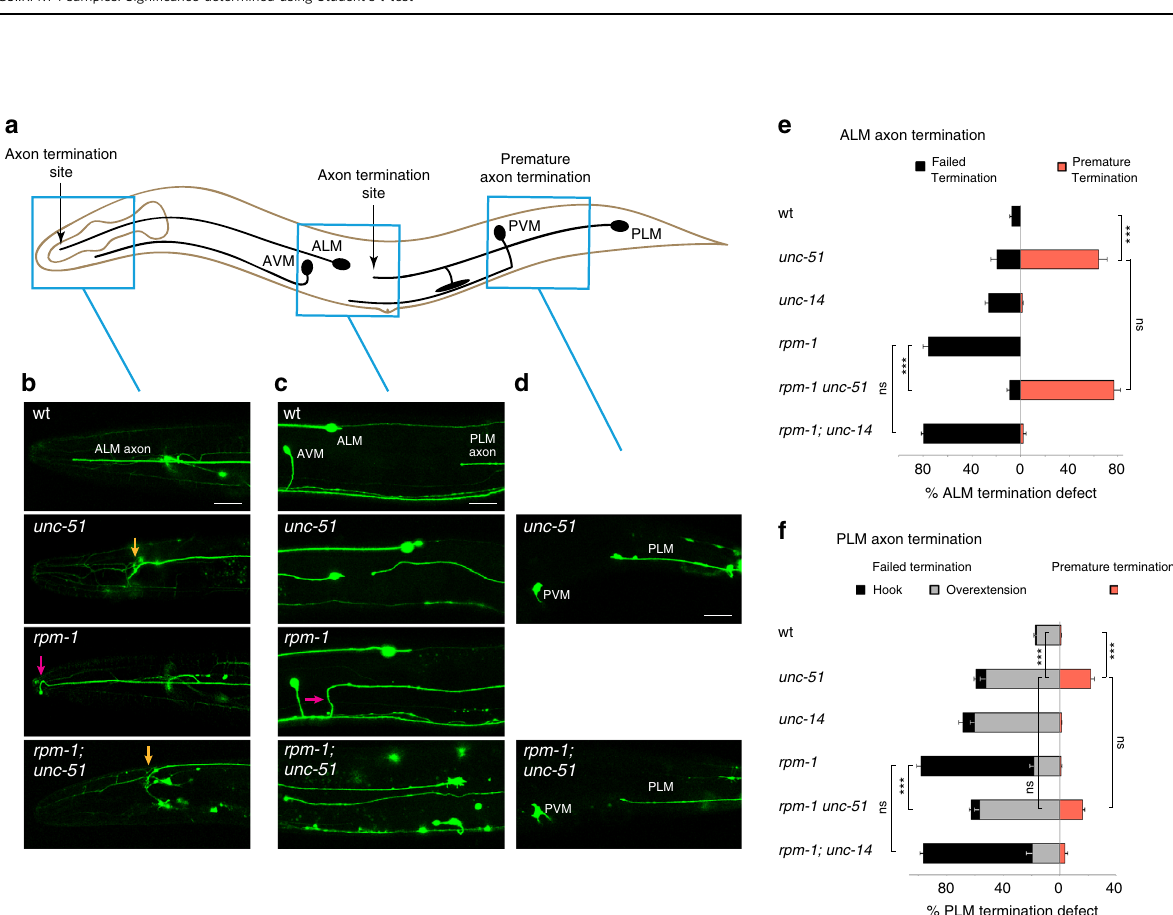
Fig. 2 RPM-1 inhibits UNC-51 to regulate axon termination. a Schematic of C. elegans mechanosensory neurons. Blue boxes highlight locations of ALM and PLM axons imaged in panels below by confocal microscopy. b Representative images of ALM axons for indicated genotypes visualized using transgenic GFP. Note failed termination (magenta arrow) in rpm-1 mutants compared with premature termination (orange arrow) in both unc-51 single mutants and rpm-1; unc-51 double mutants. c Representative images of PLM axons for indicated genotypes. rpm-1 mutants display severe failed termination defects (hook, magenta arrow), while rpm-1; unc-51 double mutants display less severe failed termination defects (overextension). d Representative images of premature termination defects observed in PLM neurons of unc-51 single mutants and rpm-1; unc-51 double mutants. e Quantitation of failed termination and premature termination defects in ALM neurons for indicated genotypes. Failed termination defects are suppressed in rpm-1; unc-51 double mutants, but not rpm-1; unc-14 double mutants. f Quantitation of failed termination and premature termination defects in PLM neurons for indicated genotypes. Severe hook defects are suppressed in rpm-1; unc-51 double mutants, but not rpm-1; unc-14 double mutants. Means are shown from 5 to 8 counts (25 – 35 animals/ count) for each genotype, and error bars represent SEM. Signi fi cance determined using Student ’ s t test with Bonferroni correction. *** p < 0.001; ns, not signi fi cant. Scale bars 20 μ m. Source data are provided as a Source Data fi